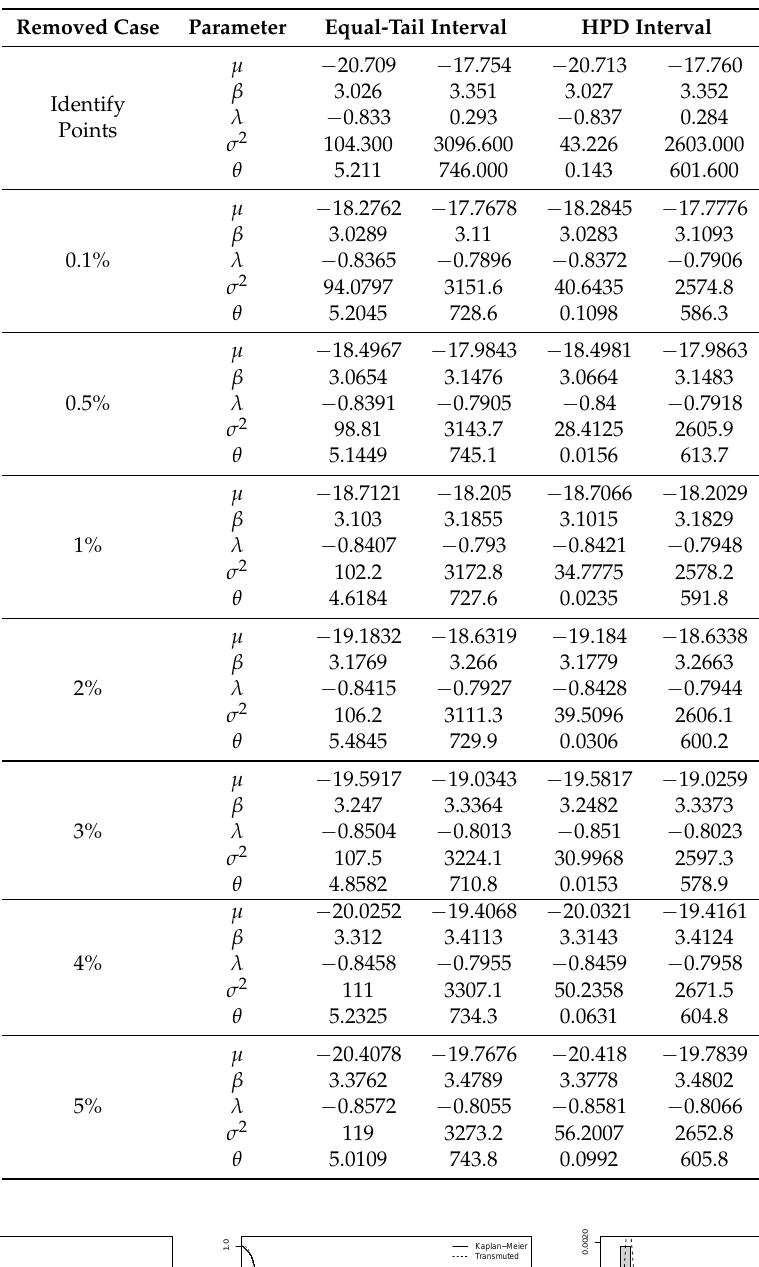
Table 6. 95% Credible Interval of parameters estimated.